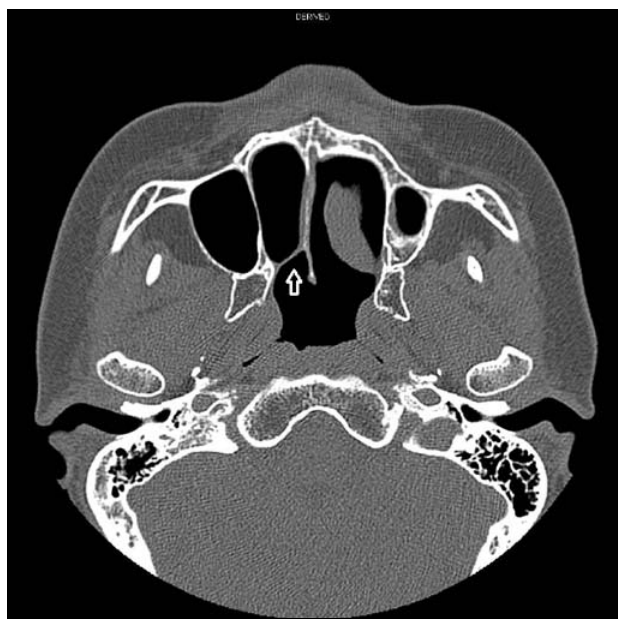
Fig. 1. Axial CT image demonstrates thin membrane occluding the right choanal lumen. No ossification is seen.